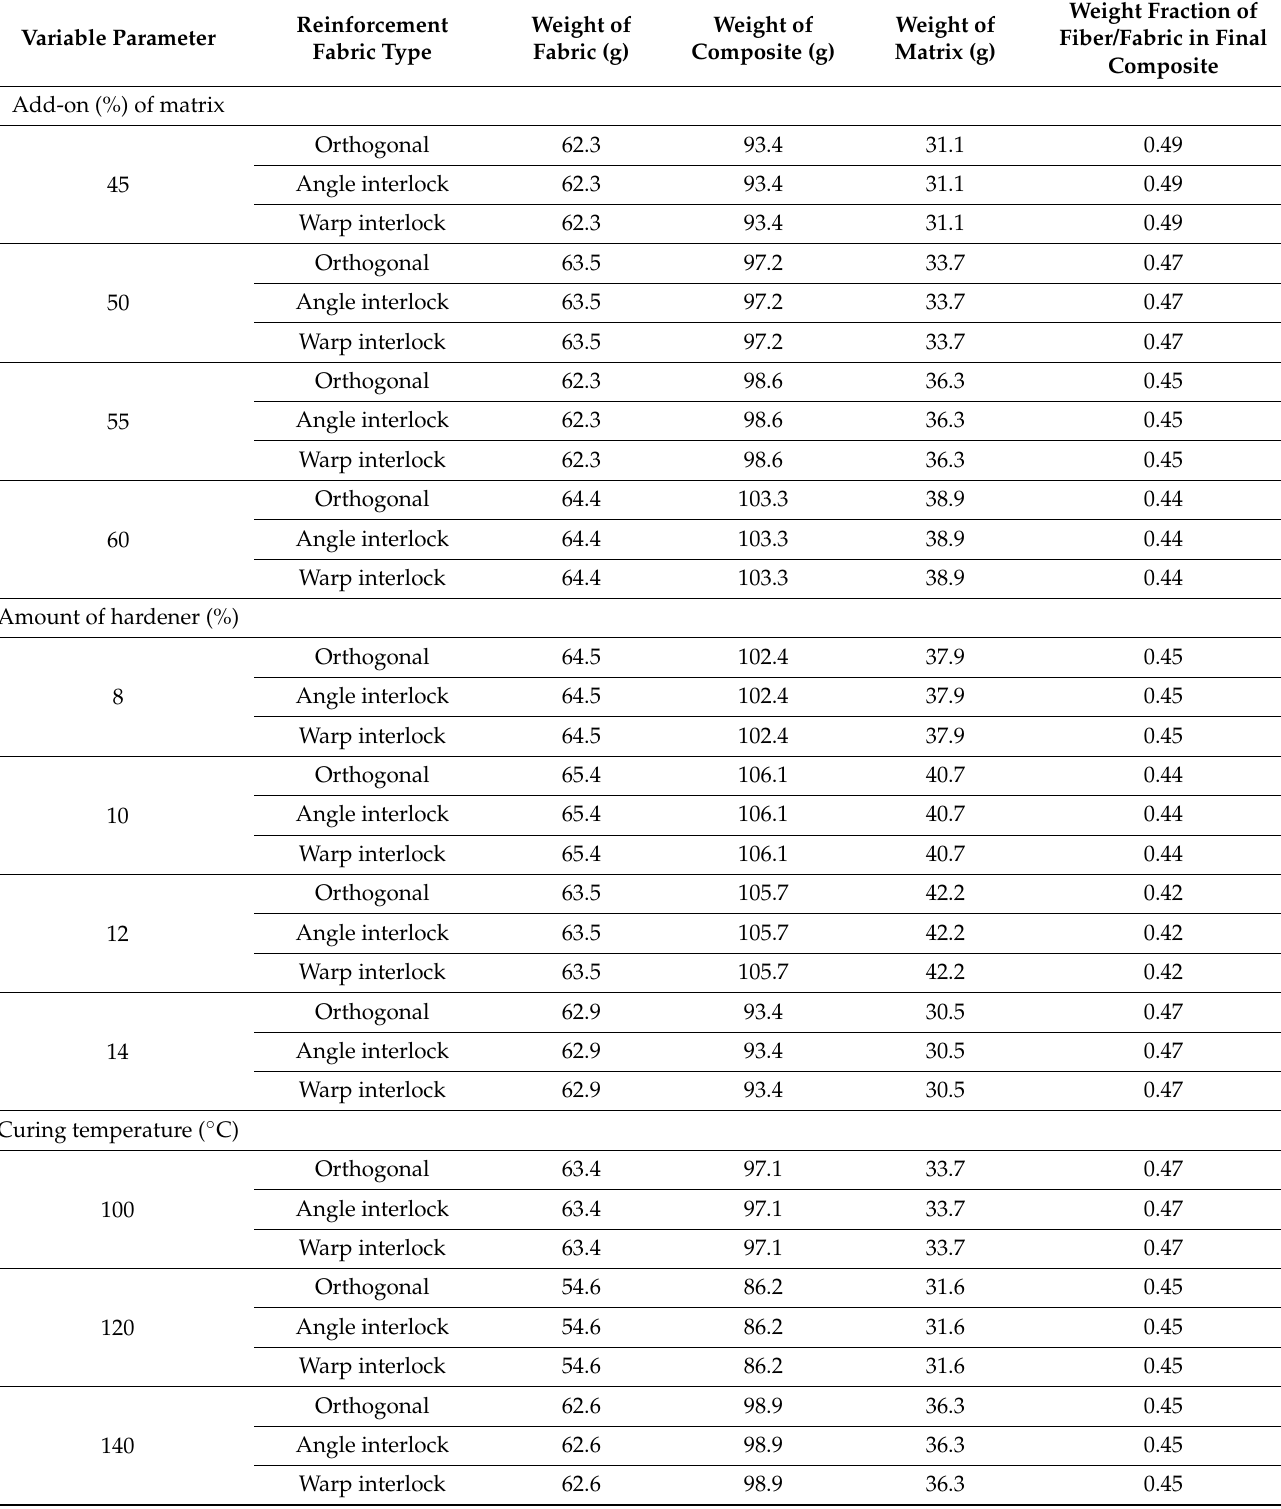
Table 2. Specification of various composite samples developed with variable